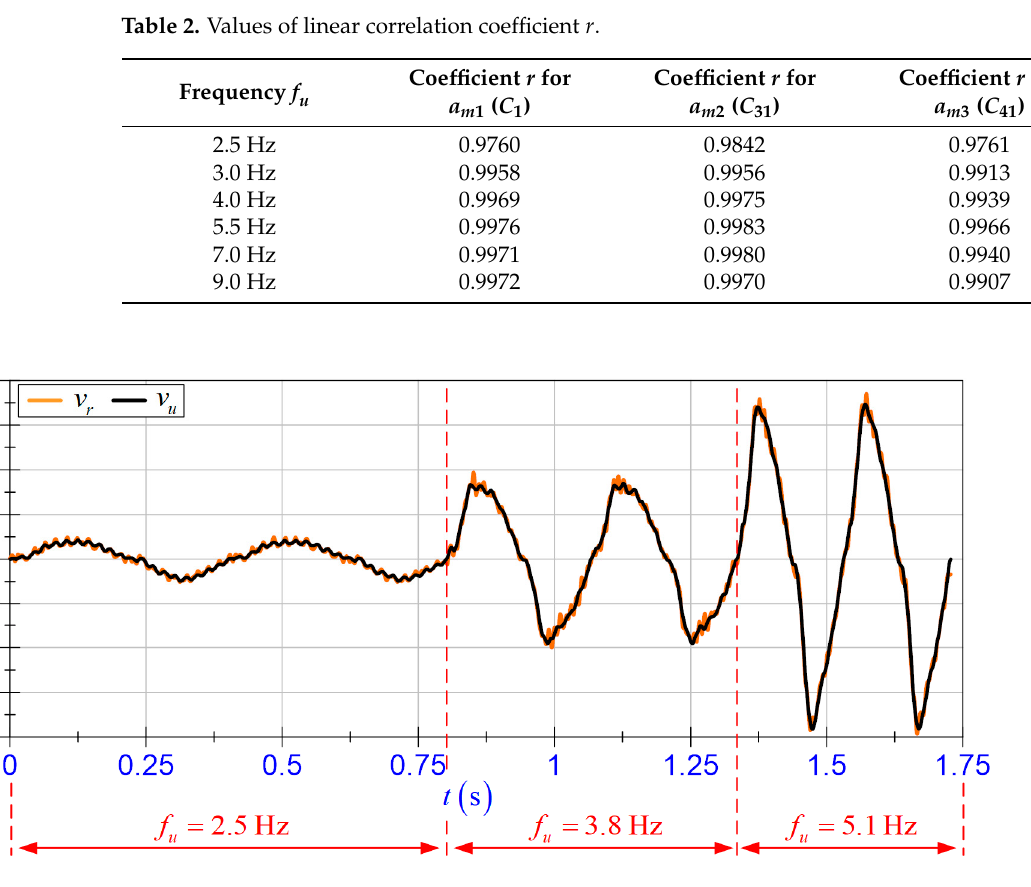
Figure 13. Time patterns of velocity v r and v u for C 41